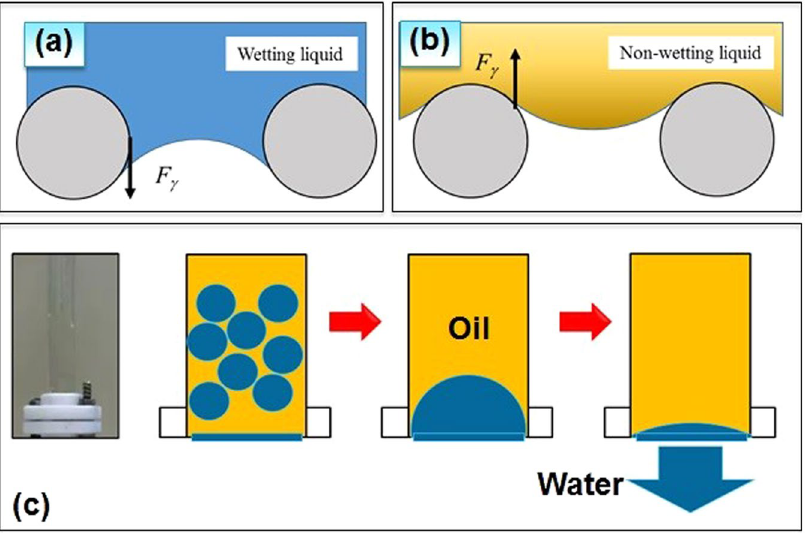
Figure 4. ( a ) The direction of the capillary force (F γ ) of wetting liquid phase, ( b ) The direction of the capillary force (F γ ) of Non-wetting liquid phase and ( c ) the suggested mechanism of oil-water separation due to the opposite directions of the capillary forces of wetting water and non-wetting oil phases. The oil water separation is possible because of the difference in the direction of the capillary forces for oil and water. The water film has role as a barrier to prevent the oil from penetrating the mesh. When the oil phase comes in contact with the coated mesh, it will be sustained by the capillary force of oil in which the direction is the opposite of the weight force. On the other hand, when water phase comes, it will be diffused with the water layer and transferred to the other phase of the